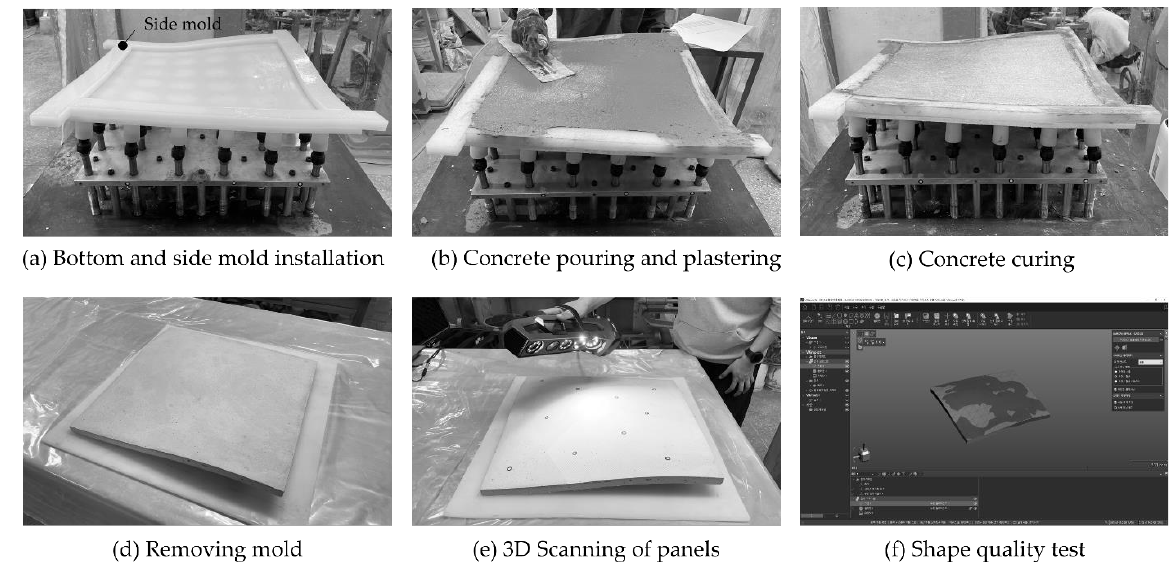
Figure 12. Free-form concrete panel fabrication and quality test process.( a ) Bottom and side mold installation, ( b ) Concrete pouring and plastering, ( c ) Concrete curing ( d ) Removing mold ( e ) 3D Scanning of panels, ( f ) Shape quality test.